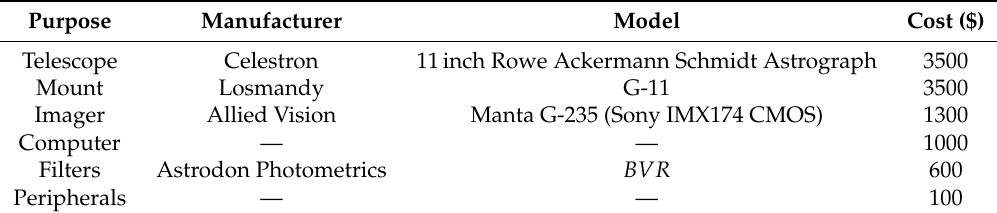
Table 1. Components of the $10,000 OSCOM small satellite tracking